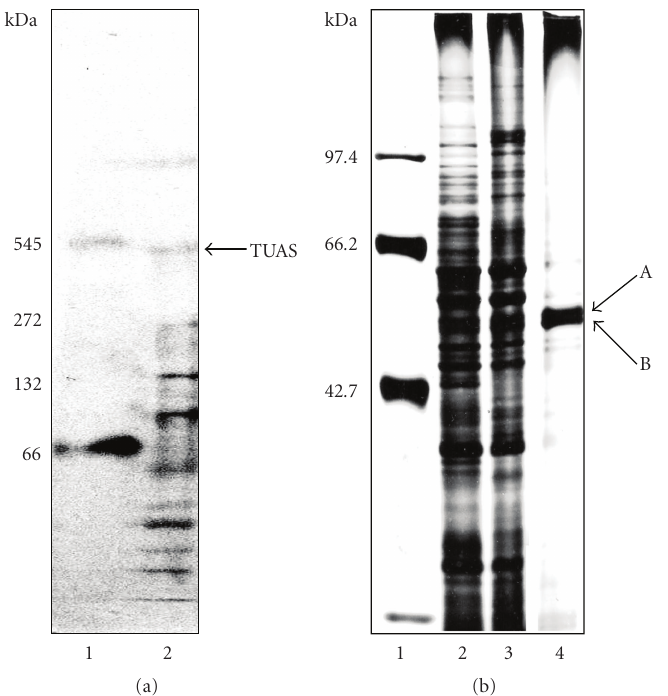
Figure 3: (a) M. luteus TUAS analyzed with native gradient PAGE. Partially purified TUAS was subjected to electrophoresis on 3–12% native gradient polyacrylamide gels (left, lane 2). Protein bands were visualized by staining with Coomassie blue. The molecular-mass standards of 545, 272, 132, and 66 kDa (top to bottom) are shown (left, lane 1). The TUAS activity is indicated with an arrow. (b) SDS-PAGE of M. luteus TUAS. Protein bands separated by 9.5% SDS-PAGE were visualized by silver staining. Lane 1: Molecular-mass standards of 97.4, 66.2, 42.7, and 31 kDa, respectively (top to bottom). Lane 2: Detergent extraction of membrane fraction. Lane 3: Protein after DEAE-cellulose column chromatography. Lane 4: TUAS purified to near homogeneity by isoelectric precipitation (pH 5.0) after DEAE-cellulose, gel filtration and adsorbent column chromatography. TUAS has two subunits A and B, upper subunit (A) is equivalent to 54 kDa and the lower subunit (B) to 52.5 kDa.